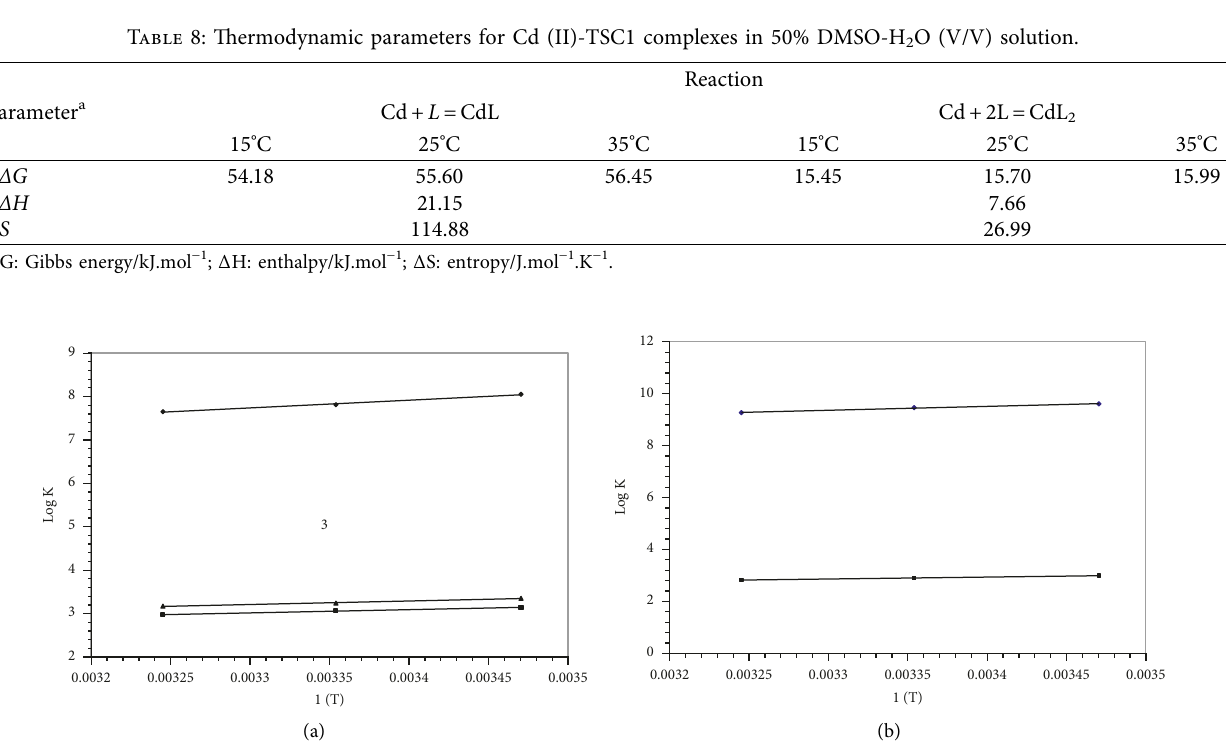
2 O (V/V) solution.